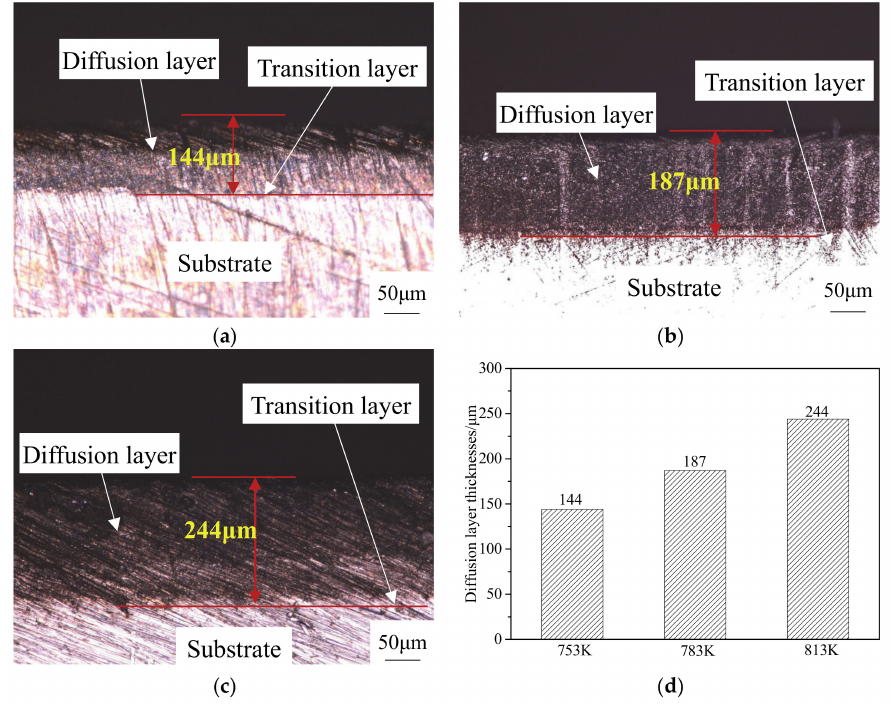
Figure 4. Cross-sectional morphology of plasma-nitrided specimen: ( a ) 753 K, 500 × ; ( b ) 783 K, 500 × ; ( c ) 813 K, 500 × ; ( d ) di ff usion layer thicknesses under di ff erent nitriding